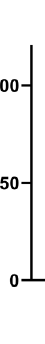
Figure 5. Total hemocyte count of cells in 10 µl from sham injected larvae incubated at 28°C at T0 and T7. Average across three replicate wells, derived from the pooled hemolymph from 10 larvae and seeded at 2 x 10 5 cells/ml. Hemocytes stained with trypan blue and dissociated with trypsin at T7 only. Errors bars = SD. Mean (and SD) cell counts of hemocytes at T0; 68 (±32) or at T7; 62